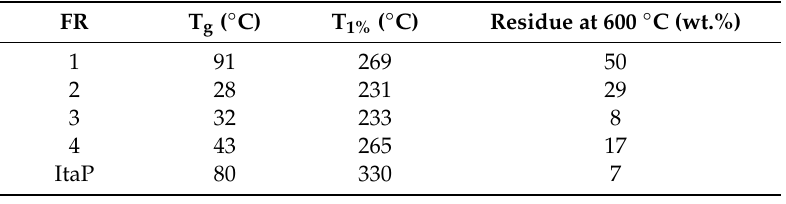
Figure 3. FR 1 (left) and FR 2 (right) before (bottom) and after (top) heating. FR 3 and FR 4 behave under heat like FR 2.